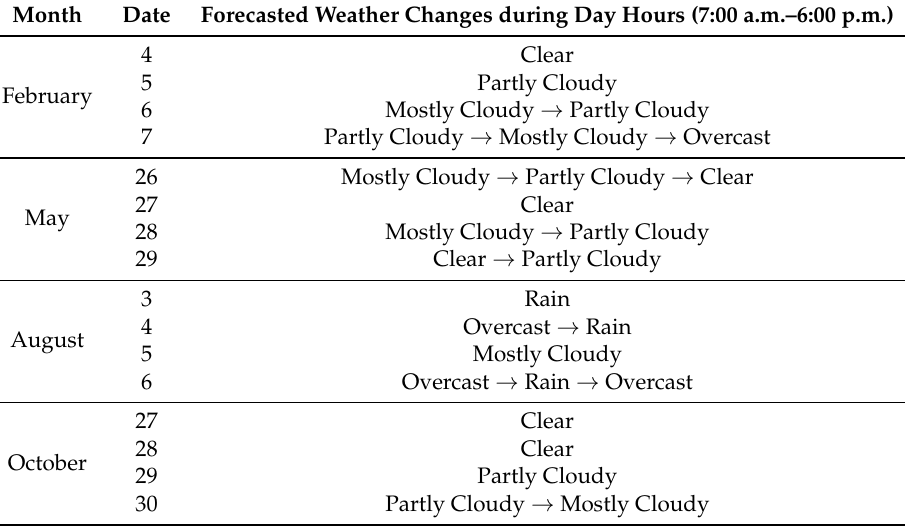
Table 6. Weather Forecast from KMA on the Exemplified